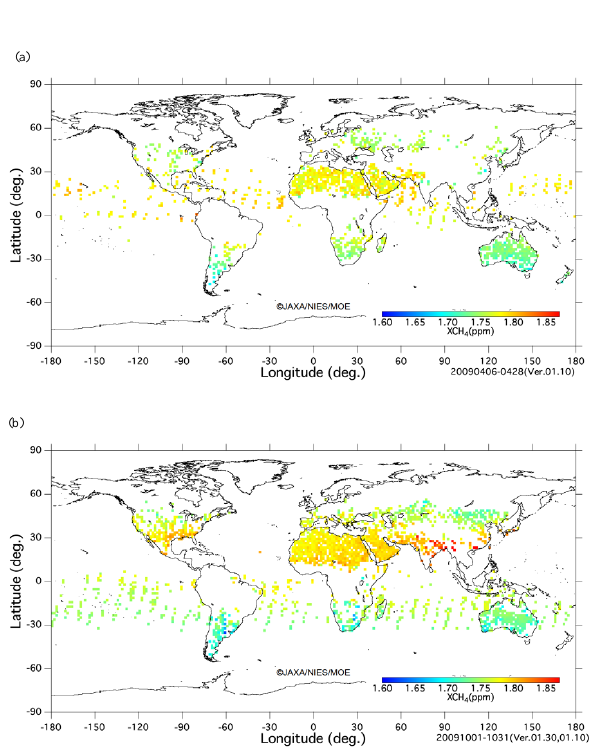
Fig. 3. Global distribution of GOSAT SWIR X CH monthly in 1.5 by 1.5 degree bins for (a) April and (b) October in